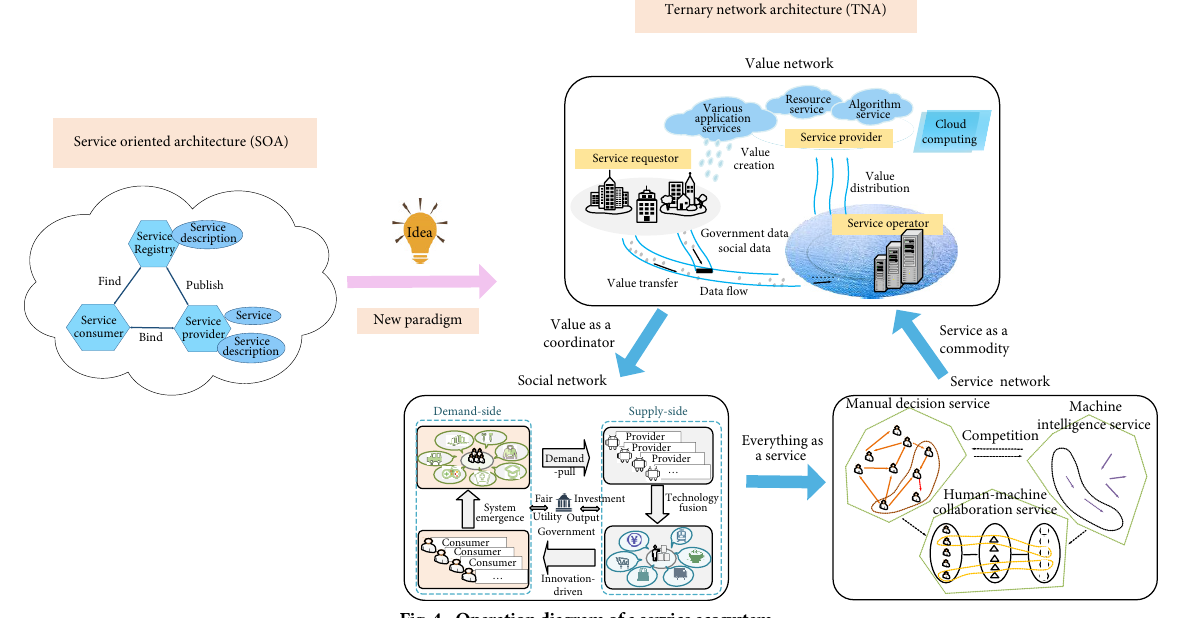
Fig. 4 Operation diagram of a service